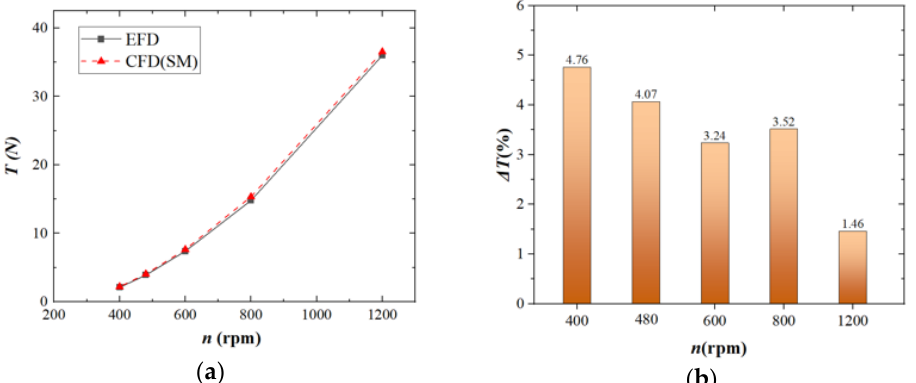
15 of 26 Figure 18. The experimental and simulation results ( a ) and error assessment ( b ) of S-AUG ( V = 0.4 m/s; Error = (EFD − CFD)/CFD × 100%). 4. Self-Propulsion Analysis of the Hybrid-Driven AUG 4.1. Test and Simulation of a Single Propeller According to the lever principle and the actual size of the tank, the thrust test mech- anism shown in Figure 19a was designed. In the test, the propeller Whale715, with a di- ameter of 0.125 m, was driven by the motor to generate thrust, as shown in Figure 19b,c. The water depth was set as 0.4 m and the inlet velocity was 0.5 m/s. During the test, by controlling the rotation rate of the propeller, the reading of the tensiometer was recorded to obtain the thrust at di ff erent rotation rates after conversion. ( a ) ( c ) Figure 19. The equipment of propeller thrust test, the thrust test bracket ( a ), Whale715 propeller